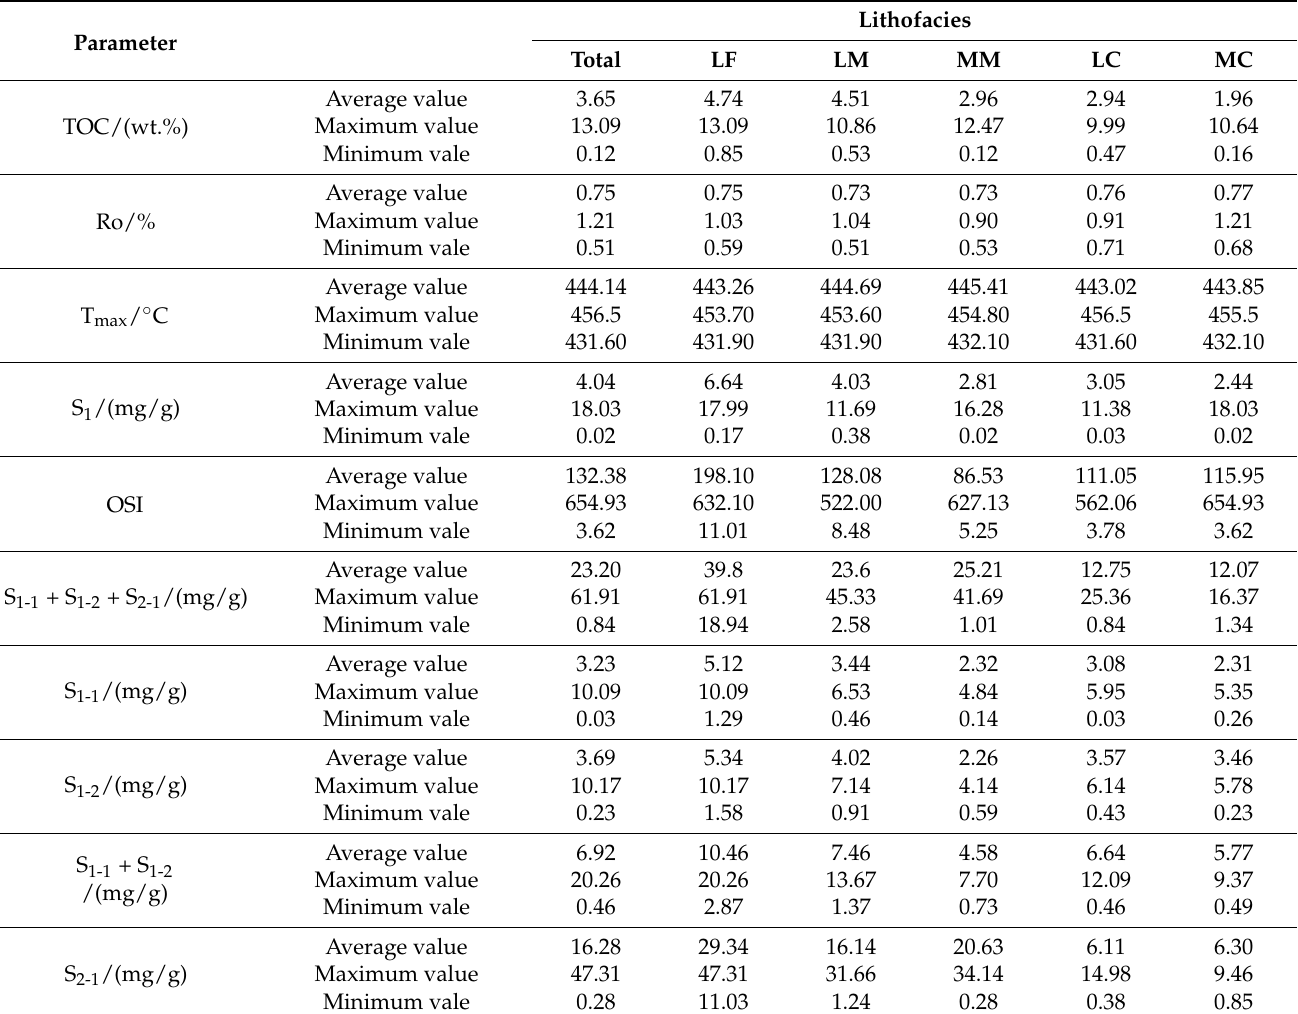
Table 1. Organic geochemical parameters of the Ek 2 shales in the Cangdong